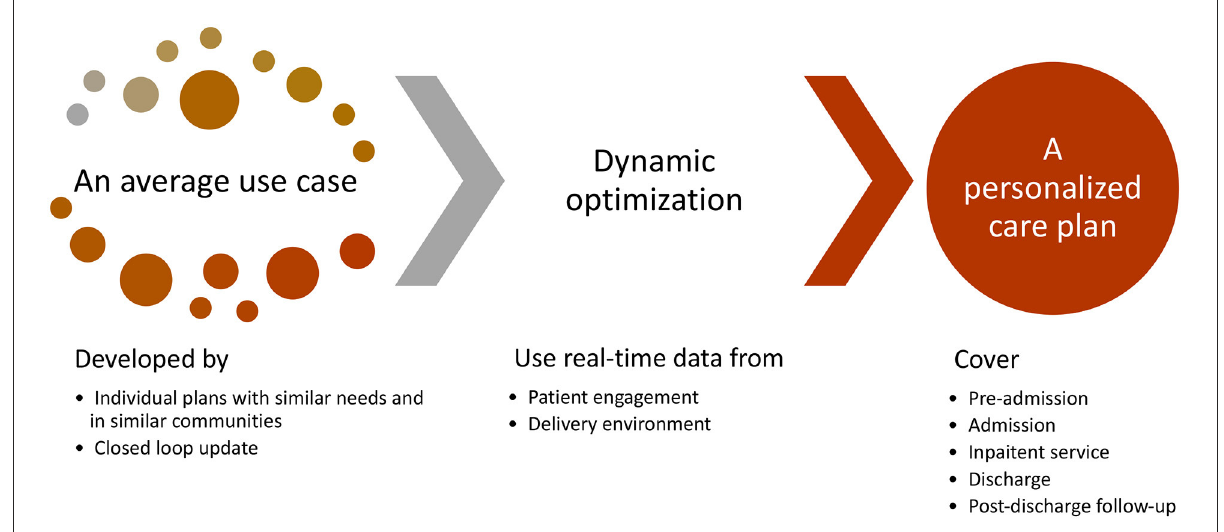
FIGURE1 Data-driven integrated